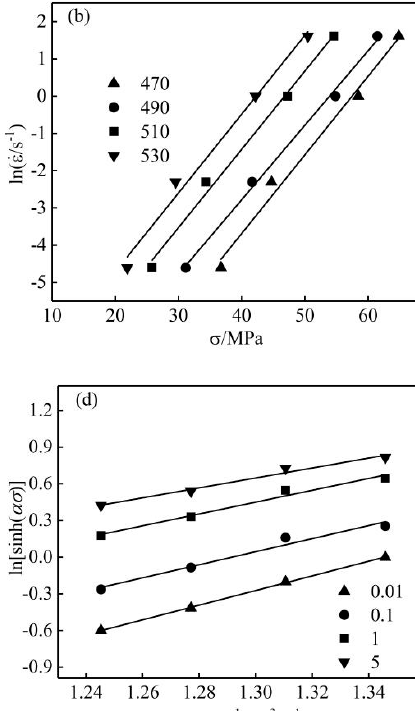
Figure 5. Scatter diagrams and linear regression fits: ( a ) ln 𝜀(cid:4662) -ln σ ; ( b ) ln 𝜀(cid:4662) - σ ; ( c ) ln 𝜀(cid:4662) -ln[sinh( ασ )]; ( d ) ln[sinh( ασ )]-1/T.